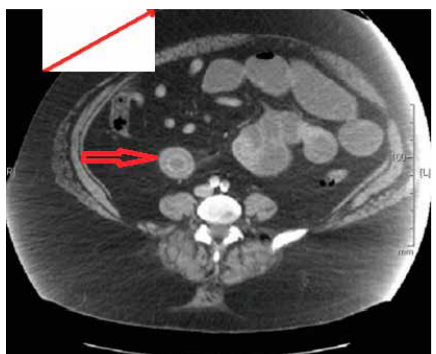
Figure 3: Contrast CT scan depicting gallstone in bowel (short red arrow).